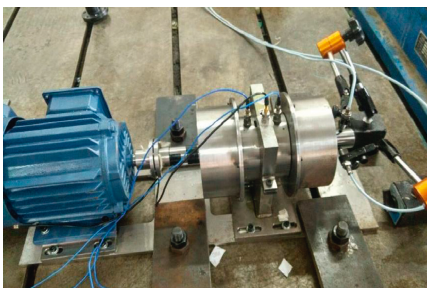
Figure 5: Experimental